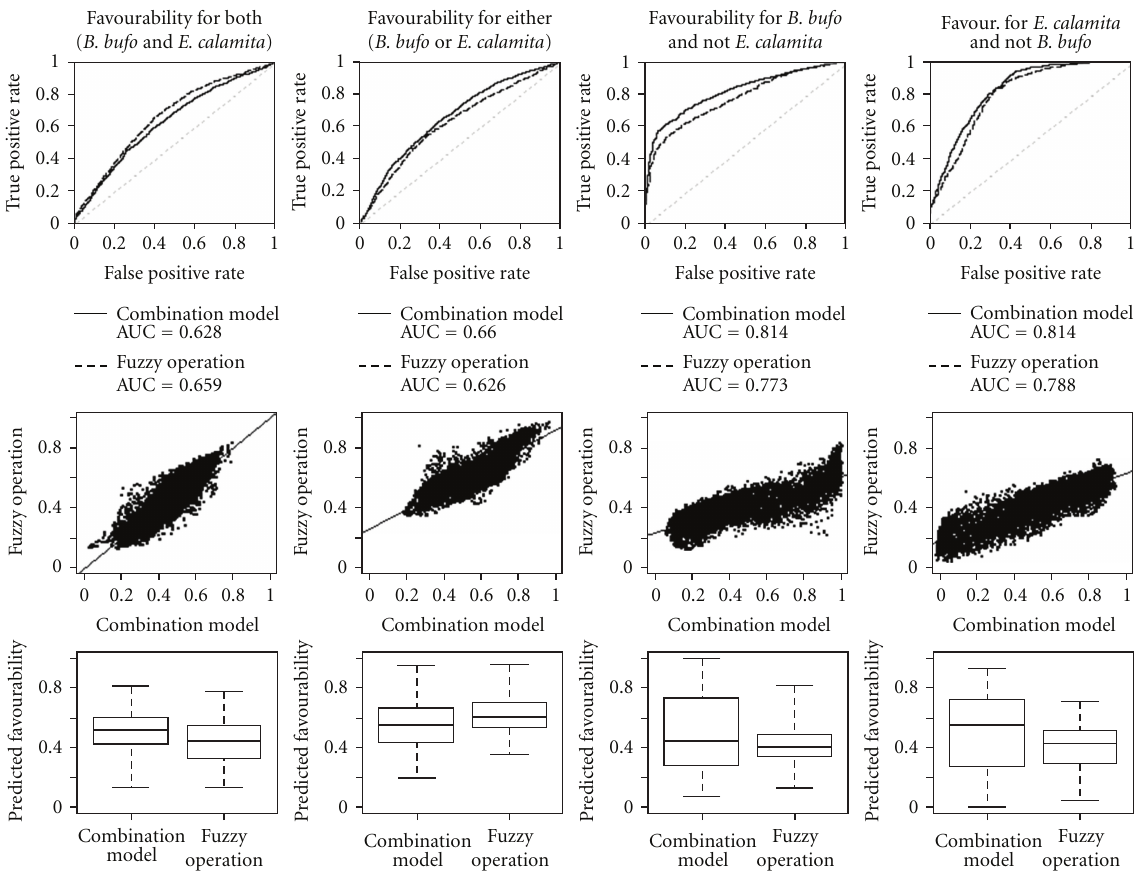
Figure 3: Top row: Comparison of the receiver operating characteristic (ROC) curves and the areas under them (AUC) for models of combined species data and the corresponding fuzzy logic operations between individual species models. Middle row: Scatter plots and linear regression lines comparing favourability values given by combined models and those given by fuzzy logic operations between individual species models. Bottom row: Box plots showing median, upper, and lower quartiles, and extreme values for favourability given by combination models and the corresponding fuzzy